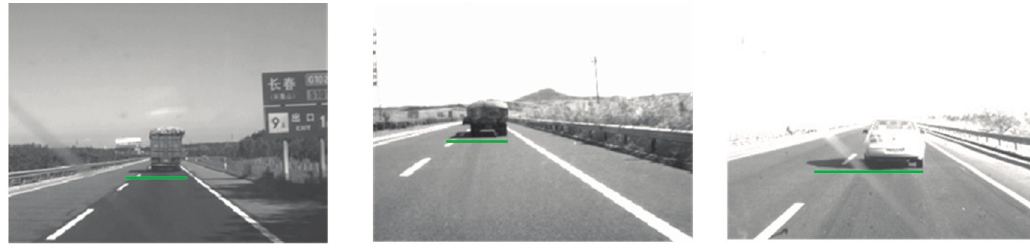
Figure 7. Vehicles cast long shadows in the scenes with low sun.